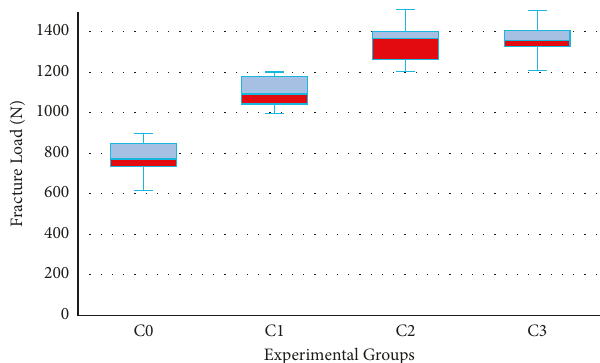
Figure 11: Boxplot of fracture load values measured in newtons